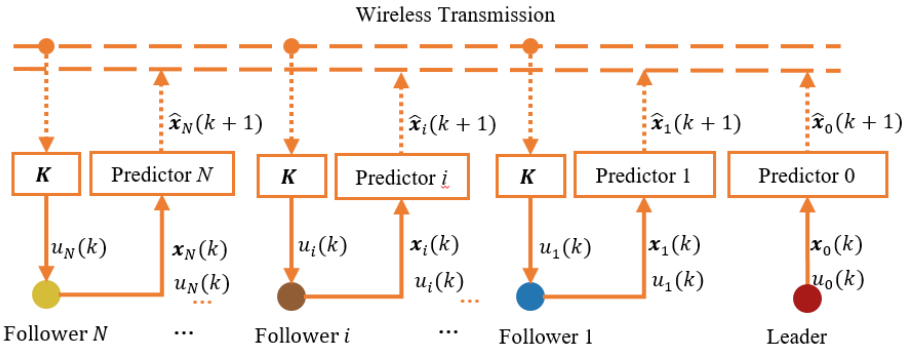
Figure 1. Problems arising from V2V. ( a ) Varieties of information flow topologies. ( b ) Fundamental of state predictor.